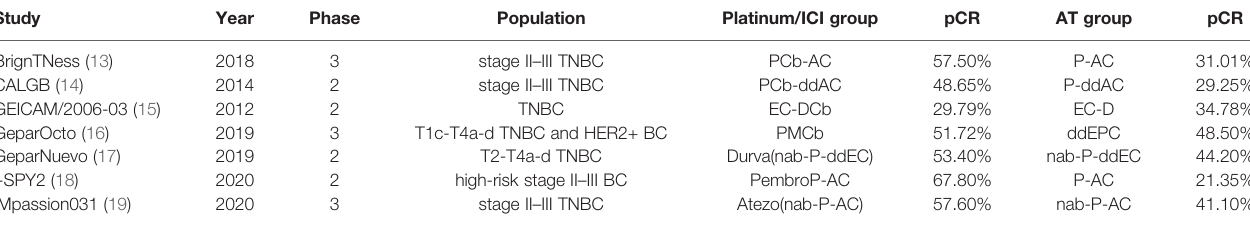
TABLE 1 | Characteristics of eligible